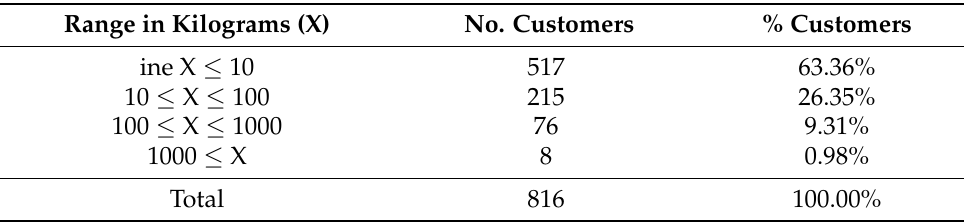
Table 2. Customer